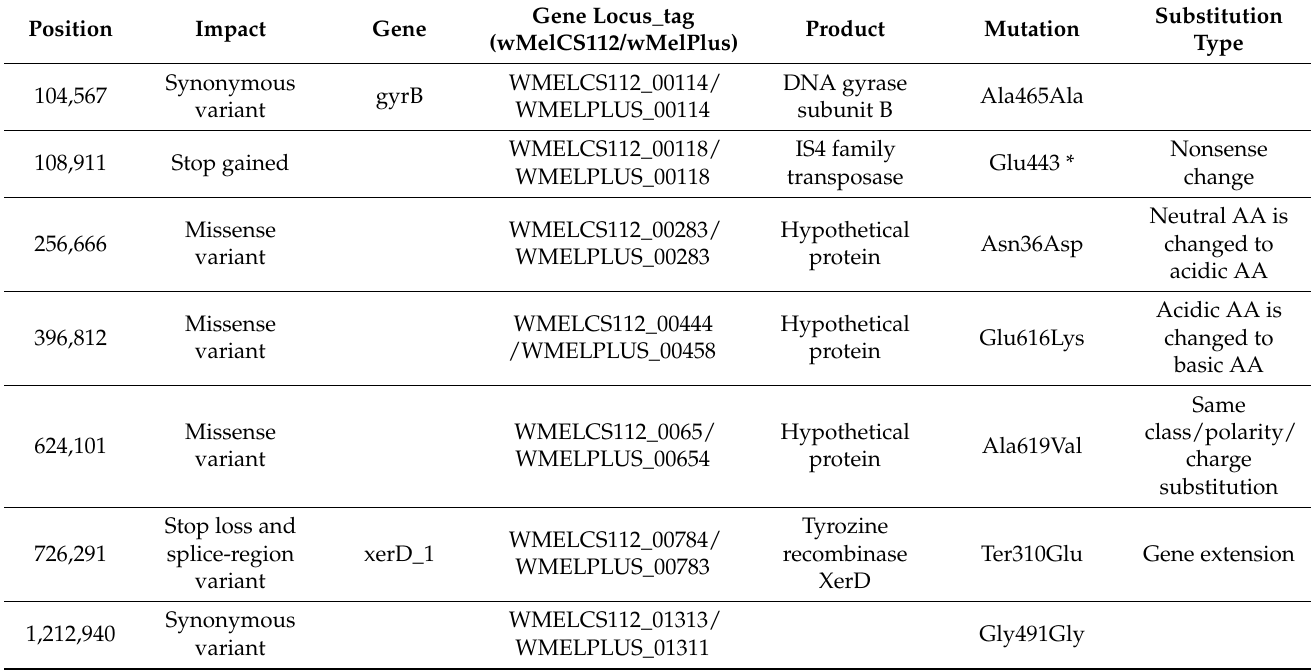
Table 3. The SNPs between the wMePlus and wMelCS 112 Wolbachia